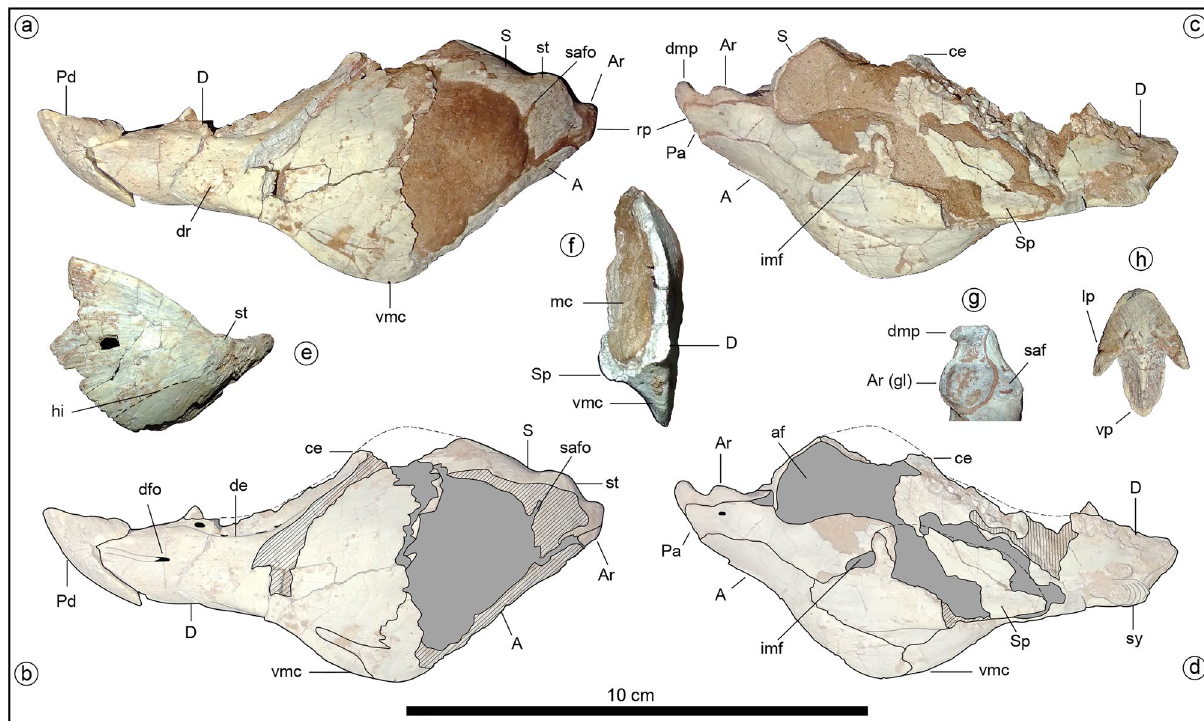
Figure 2. Holotype of Jakapil kaniukura (MPCA-PV-630), lower jaw bones. ( a ) left mandible in lateral view; ( b ) left mandible in lateral view, interpreted bone contours; ( c ) left mandible in medial view; ( d ) left mandible in medial view, interpreted bone contours; ( e ) right surangular in lateral view (mirrored); ( f ) transversal section of the posterior half of the left mandible, cranial view; ( g ) articular bone in occlusal view; ( h ) predentary bone in occlusal view. A angular, af adductor fossa, Ar articular, Ar (gl) glenoid fossa of the articular, ce coronoid eminence, D dentary, de dentary emargination, dfo dentary foramen, dmp dorsomedial process of the articular, dr dentary rugosities, hi subhorizontal inflection (dashed line), imf internal mandibular fenestra, lp lateral process of the predentary, mc Meckelian canal, Pa prearticular, Pd predentary, rp retroarticular process, S surangular, saf surangular facet for the glenoid articulation, safo surangular foramen (canal), Sp splenial, st surangular tubercle, sy mandibular symphysis, vmc ventral mandibular crest.